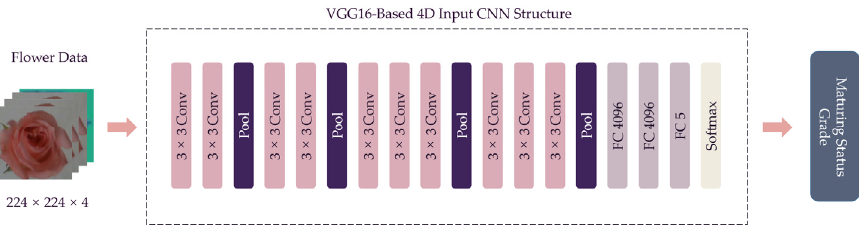
Figure 7. Structure of improved VGG16 network, where Conv represents the convolutional layer, FC represents the fully connected layer, Pool represents the pooling layer, and Softmax corresponds to an activation function.